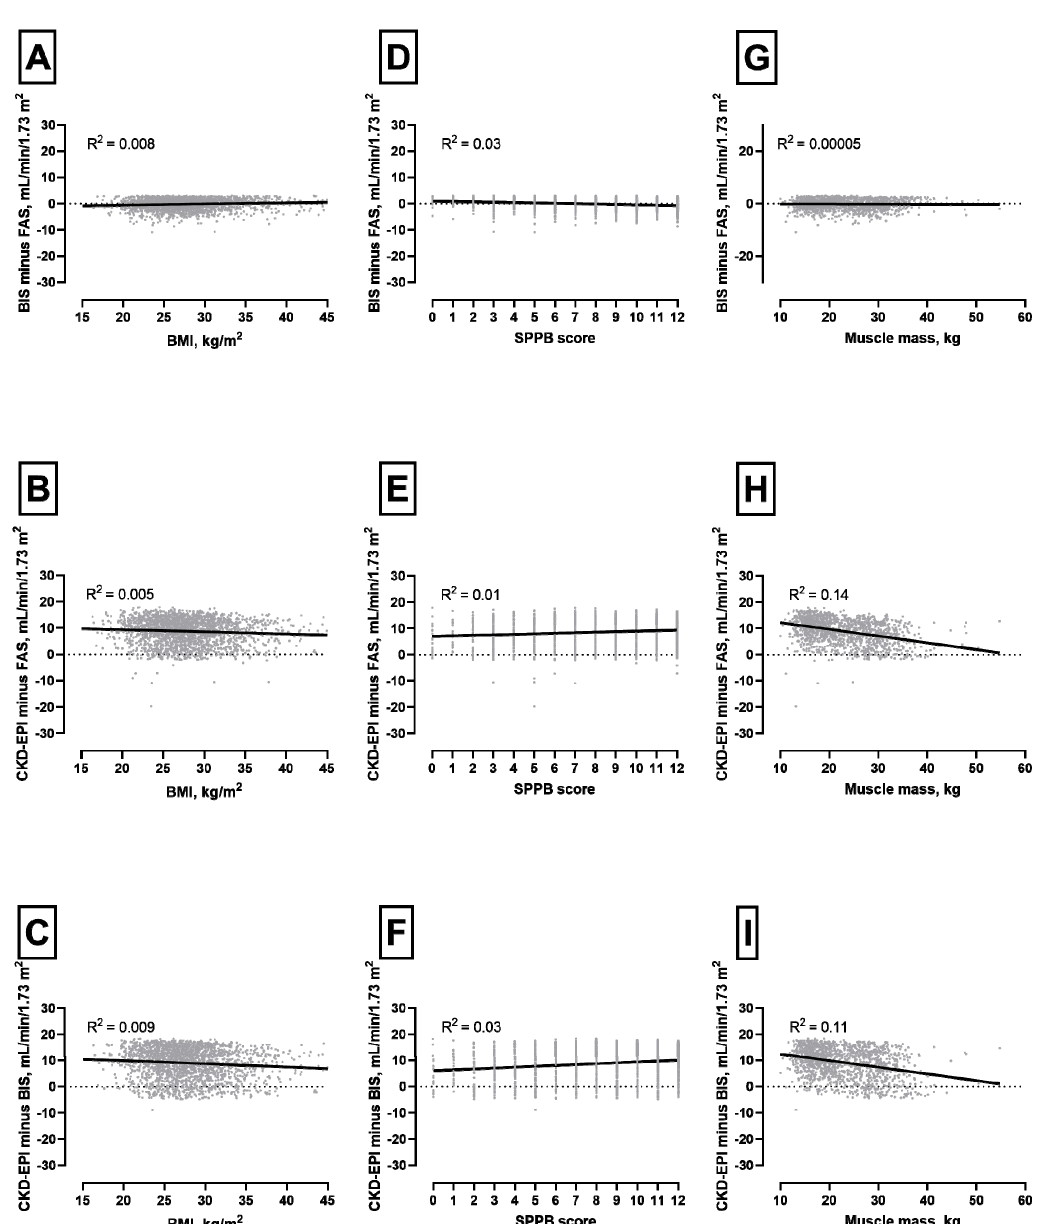
Figure 2. Graphical analysis of the impact of BMI (panels A – C ), physical performance (Panels D – F ) and muscle mass* (Panels G – I ) on the di ff erence among eGFR equations studied. *N = 1462. Figure 2 shows the graphic analysis referring to the point distribution of selected study variables in relation to the di ff erence between two equations and the correlation of BMI, SPPB and muscle mass on di ff erent calculation models of glomerular filtration rate. The choice of design was adapted on the basis of the regression curve best fitting the distribution of values. As may be seen from the figure, there is no impact of BMI and physical performance quantified by SPPB in this model on sensitivity of BIS and FAS related calculation models as well as CKD-EPI including in the models. Muscle mass seems to have no impact in models including FAS and BIS (panel D), however, as soon as CKD-EPI is included muscle mass is negatively correlated to eGFR values (CKD-EPI and BIS; R 2 = 0.14 panel H-CKD-EPI and BIS; R 2 = 0.11 panel I).